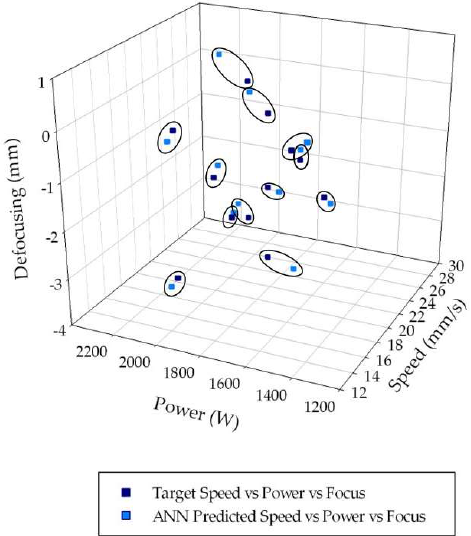
Figure 5. Experimental (blue marks) and artificial neural networks (ANN)-estimated (light blue marks) power values, p , for each of the p = 12 experimental conditions.